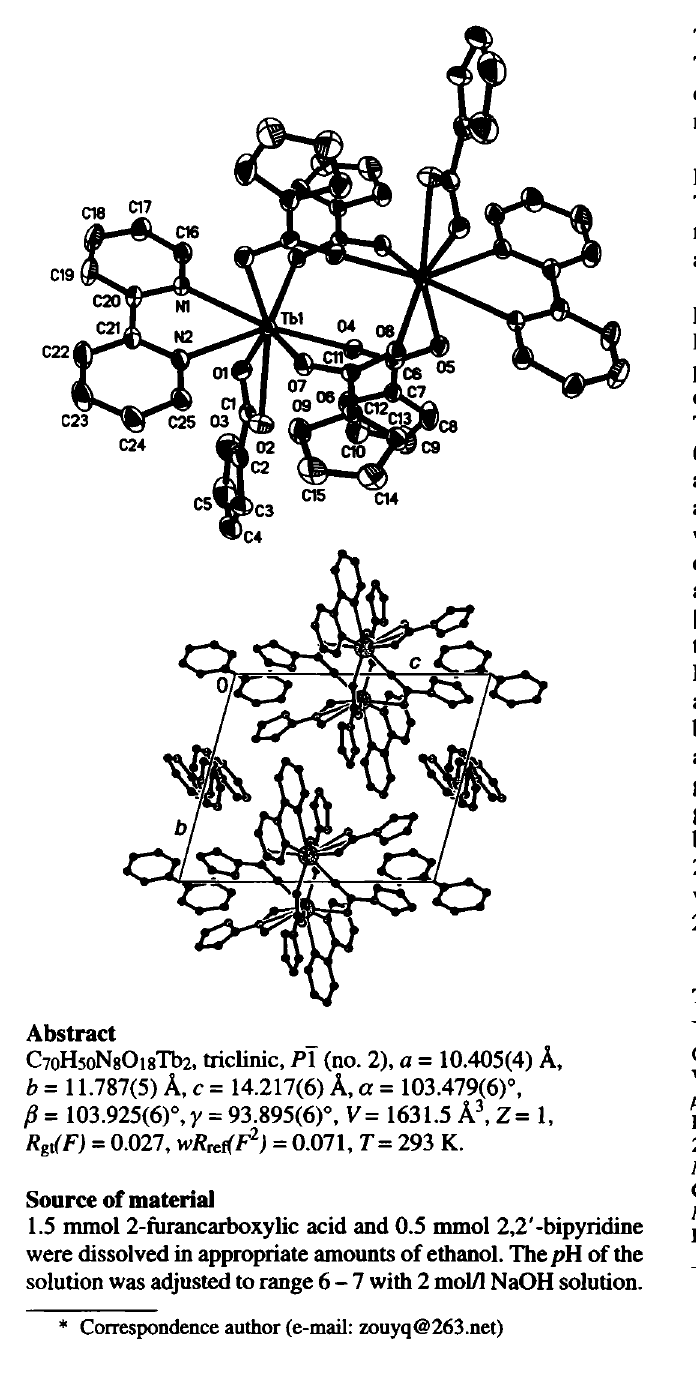
Table 1. Data collection and